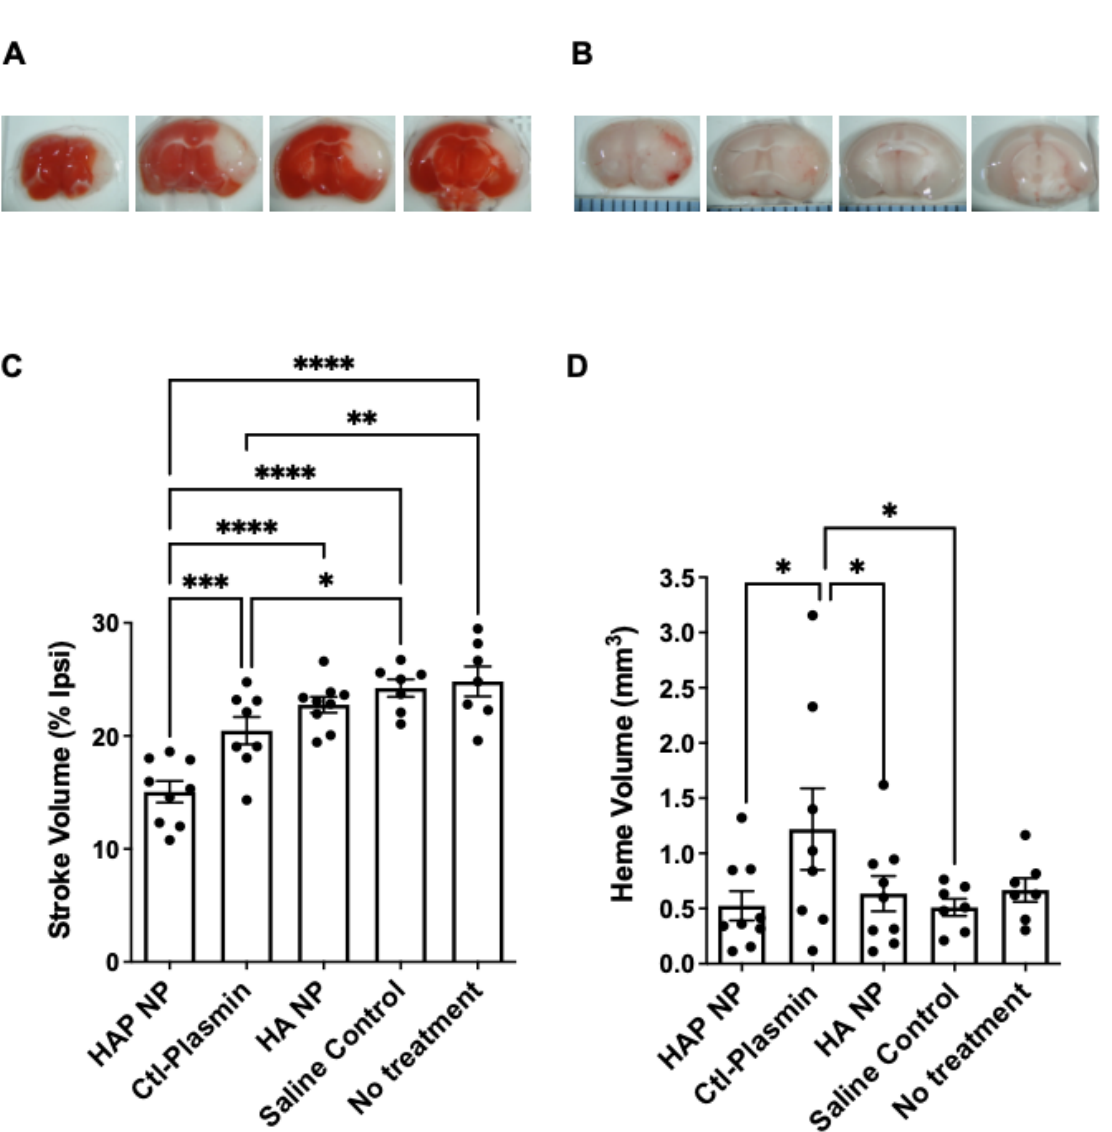
Figure 7. Treatment with HAP particles reduced stroke infarct volume without overt increases in hemorrhagic transfor- mation following MCAO. ( A ) Representative images of TTC staining of coronal brain sections from one mouse 72 h after MCAO. ( B ) Representative images of coronal brain sections from one mouse showing hemorrhage 72 h after